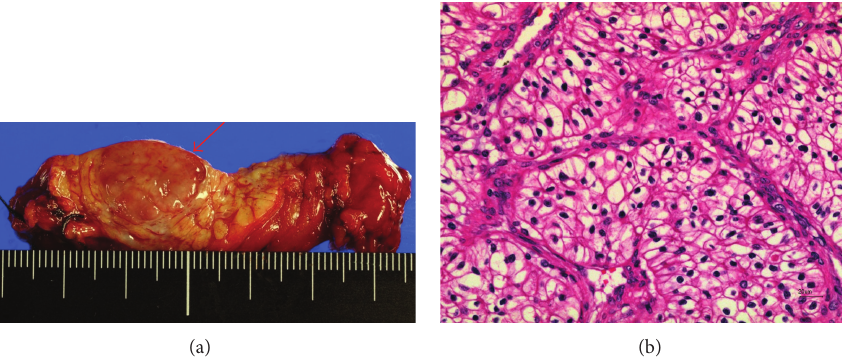
Figure 3: (a) The macroscopic findings showed a single well-circumscribed tumor in the resected specimen. (b) A histological examination revealed metastasis of renal cell carcinoma with the same features as the previously resected specimen (hematoxylin-eosin